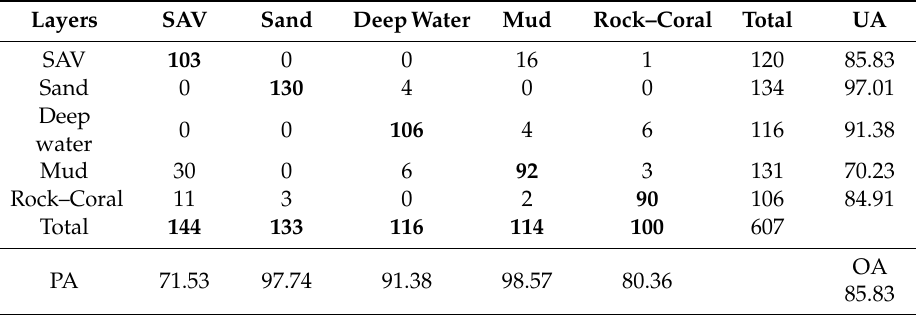
Table A1. Landsat-5 confusion matrix table (2008).